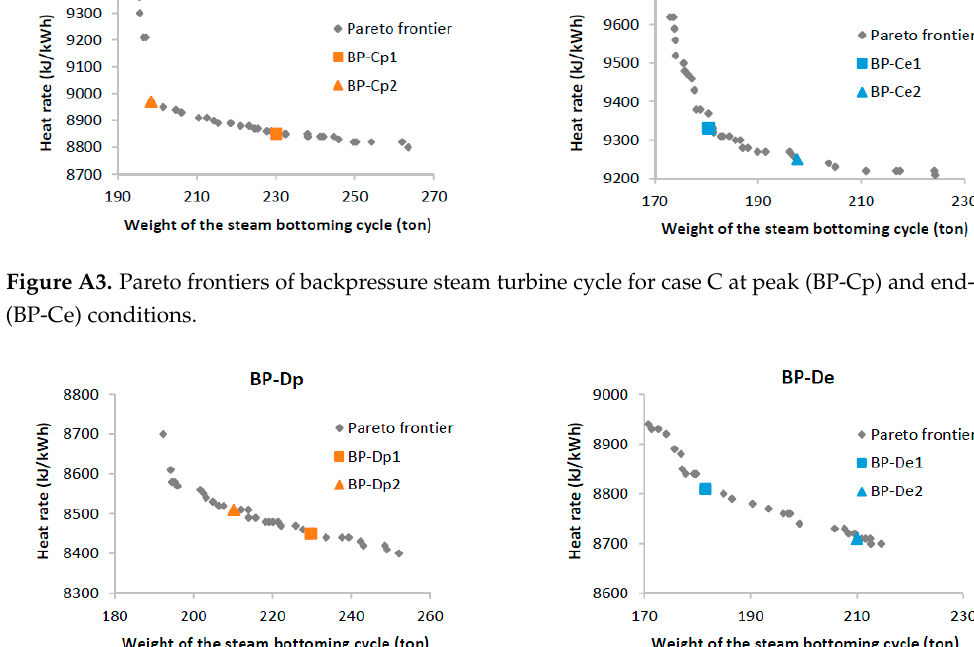
Figure A2. Pareto frontiers of backpressure steam turbine cycle for case B at peak (BP-Bp) and end- life (BP-Be) conditions.